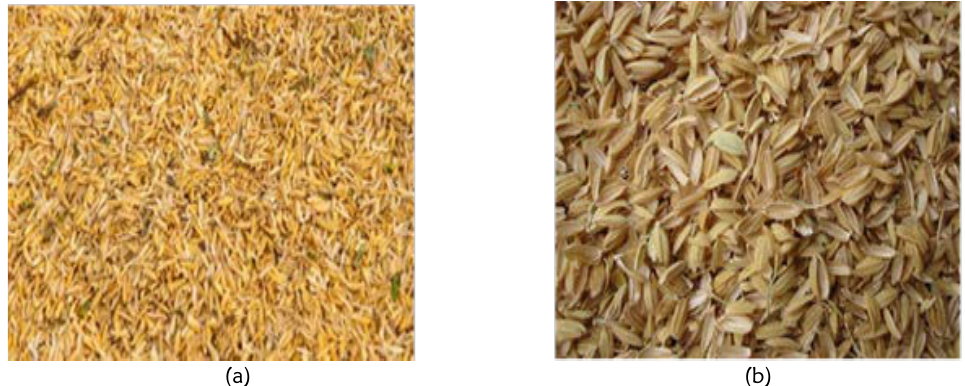
Figure 3: Rice husk (a) before physical treatment and (b) after physical treatment.